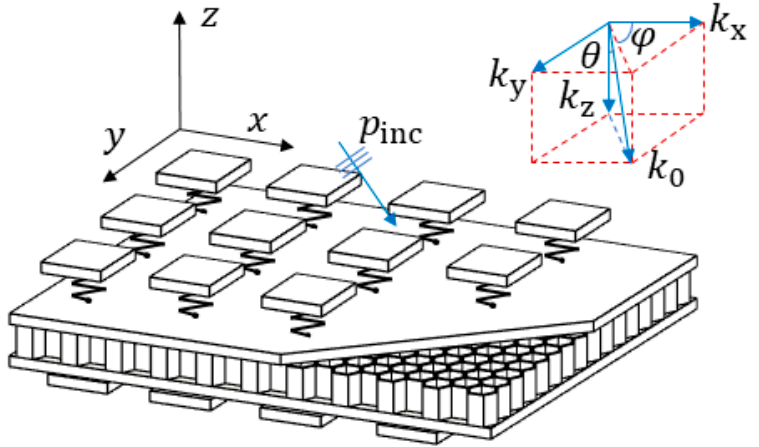
Figure 6. Schematic diagram of the sound transmission.